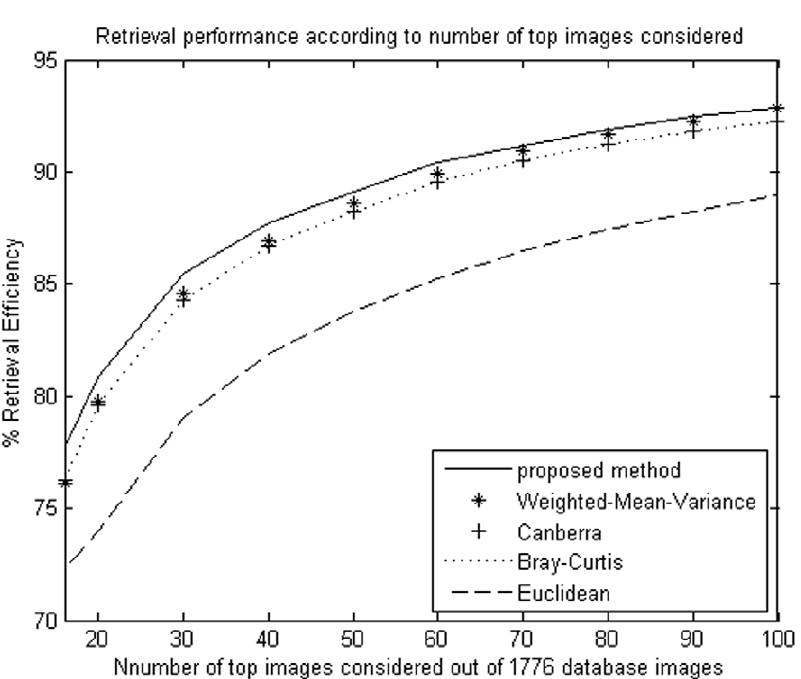
Figure 8. Average retrieval rate of database according to the number of top retrieved images using DT-CWT. The Brodatz image database (1776 images) were used.